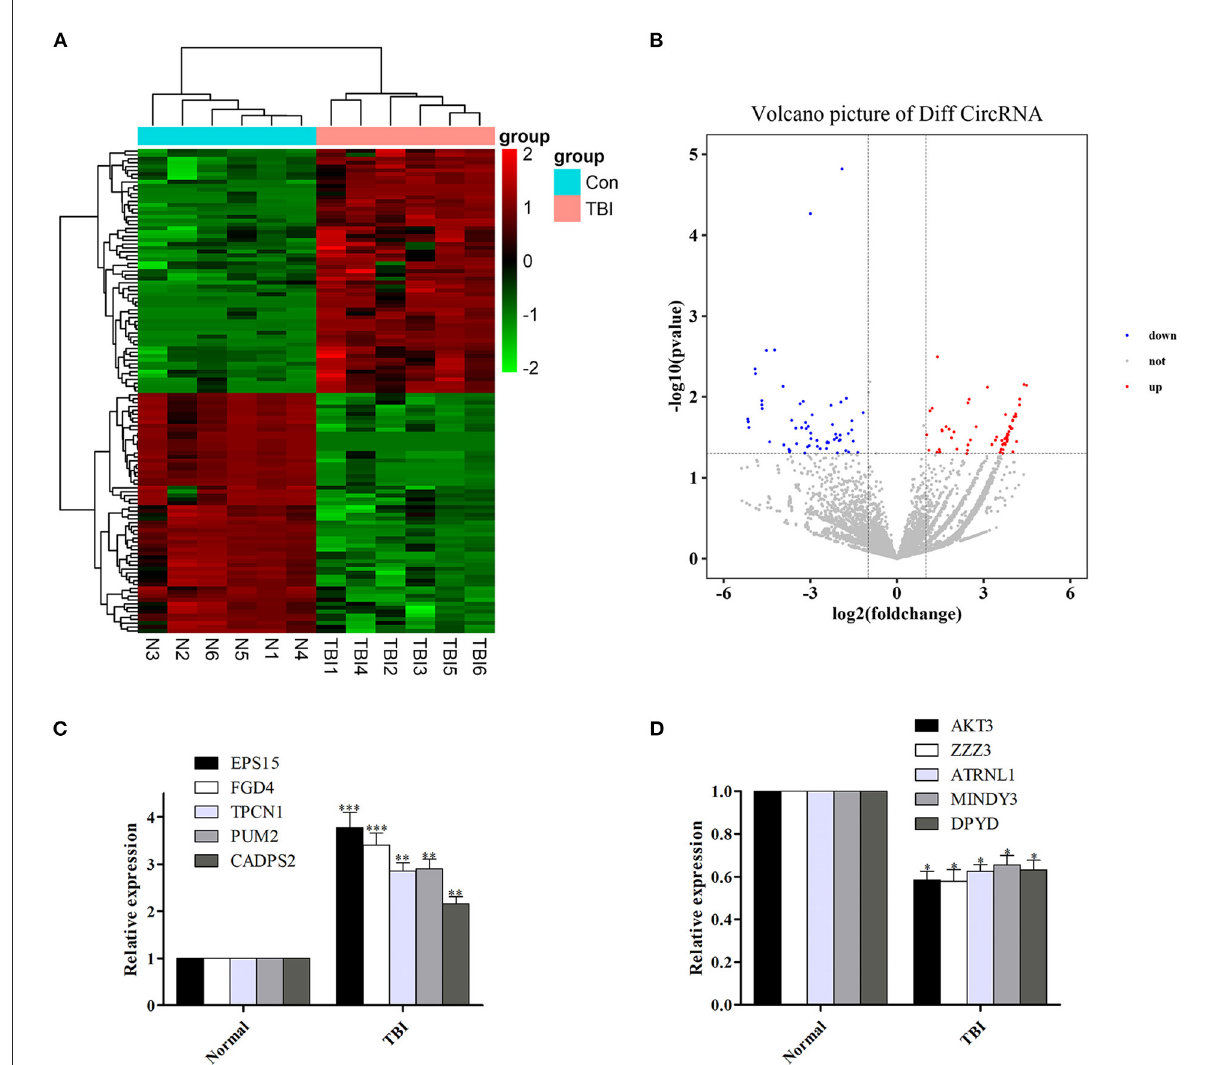
FIGURE1 Differentially expressed circRNAs in human TBI tissues, and verify the reliability of sequencing results by qRT-PCR. (A, B) Differentially expressed circRNAs in human TBI tissues. (C) The expression of the top five up-regulated circRNAs was increased in human TBI tissues. (D) The expression of the top five down-regulated circRNAs was decreased in human TBI tissues. n = 6 per group. Data are presented as mean ± SEM; * P < 0.05, ** P < 0.01, *** P < 0.001 vs. adjacent brain contusion